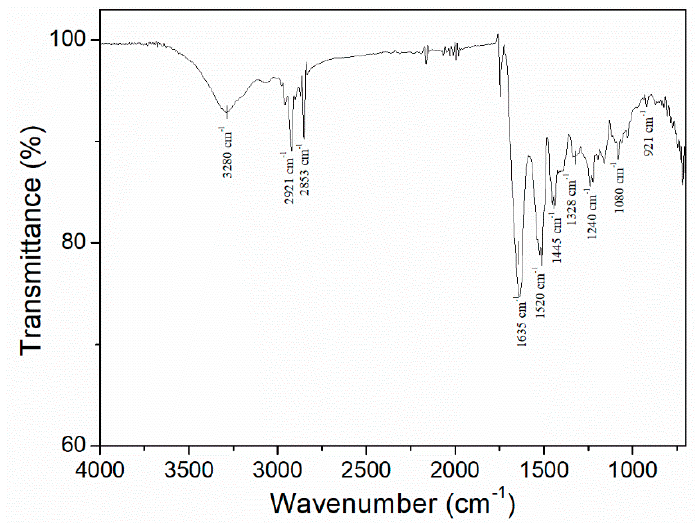
Figure 2. FTIR profile of the collagen protein isolate.